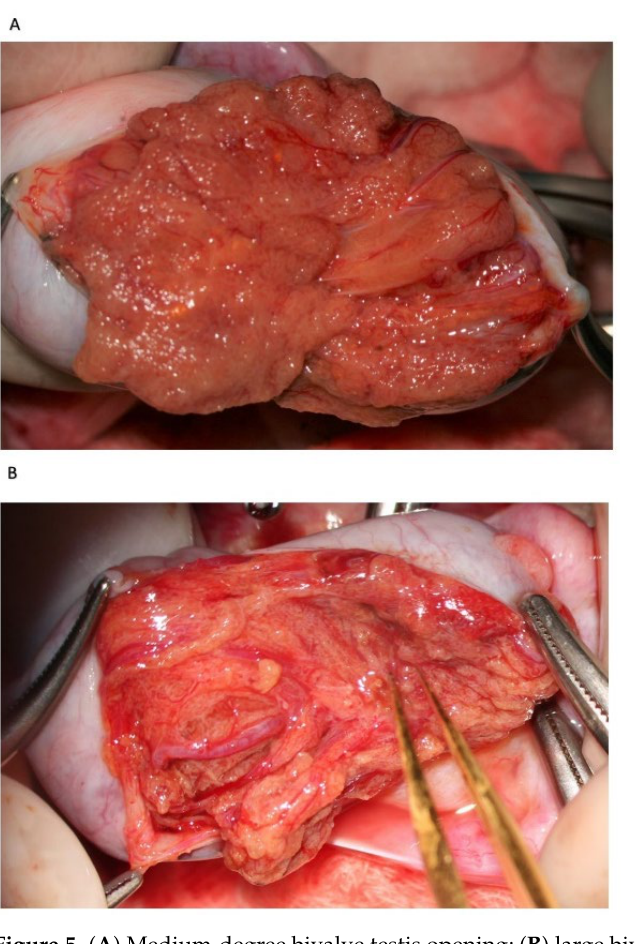
Figure 5. ( A ) Medium-degree bivalve testis opening; ( B ) large bivalve testis opening.